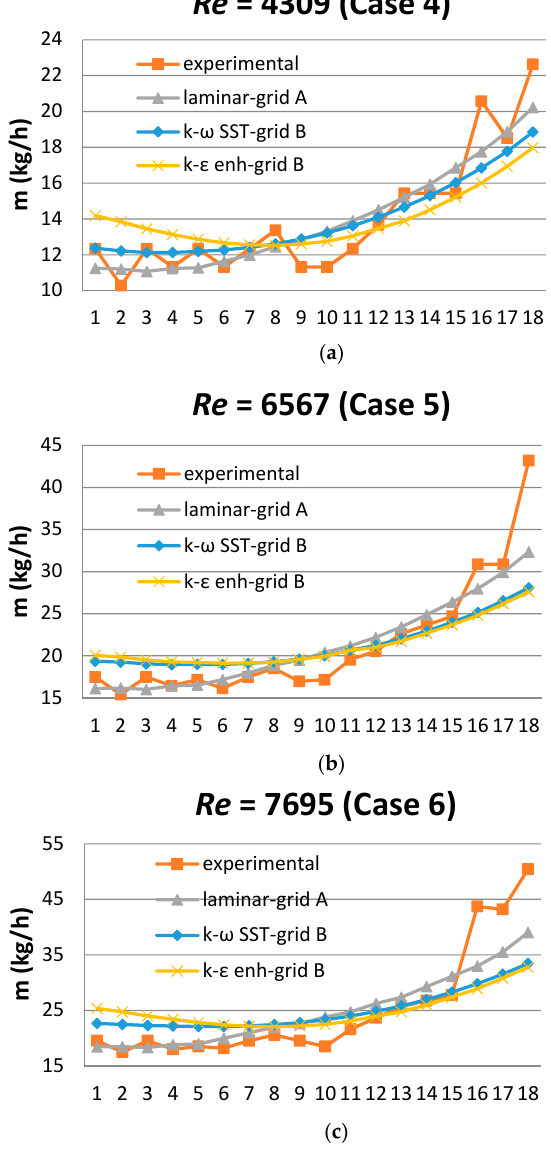
Figure 7. Comparison of numerical with experimental results. The former were produced by laminar flow simulations in grid A and turbulent flow simulations (two models) in grid B. ( a ) Re = 4309 (Case 4); ( b ) Re = 6567 (Case 5); ( c ) Re = 7695 (Case 6).